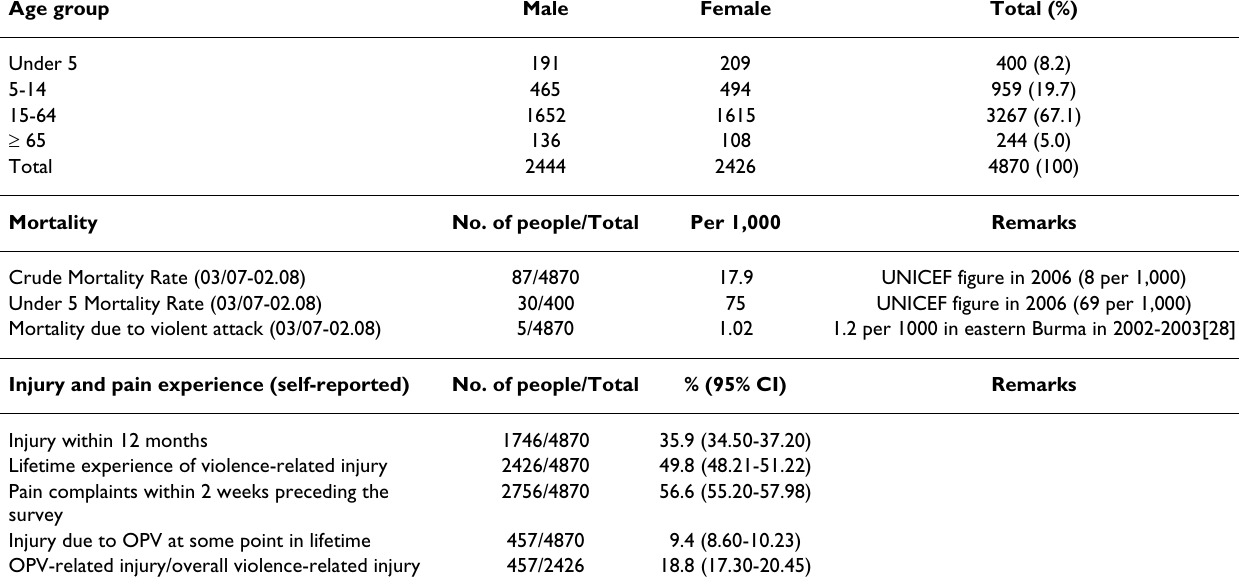
Table 2: Demographic and health indicators of study population, n = 4870 Age